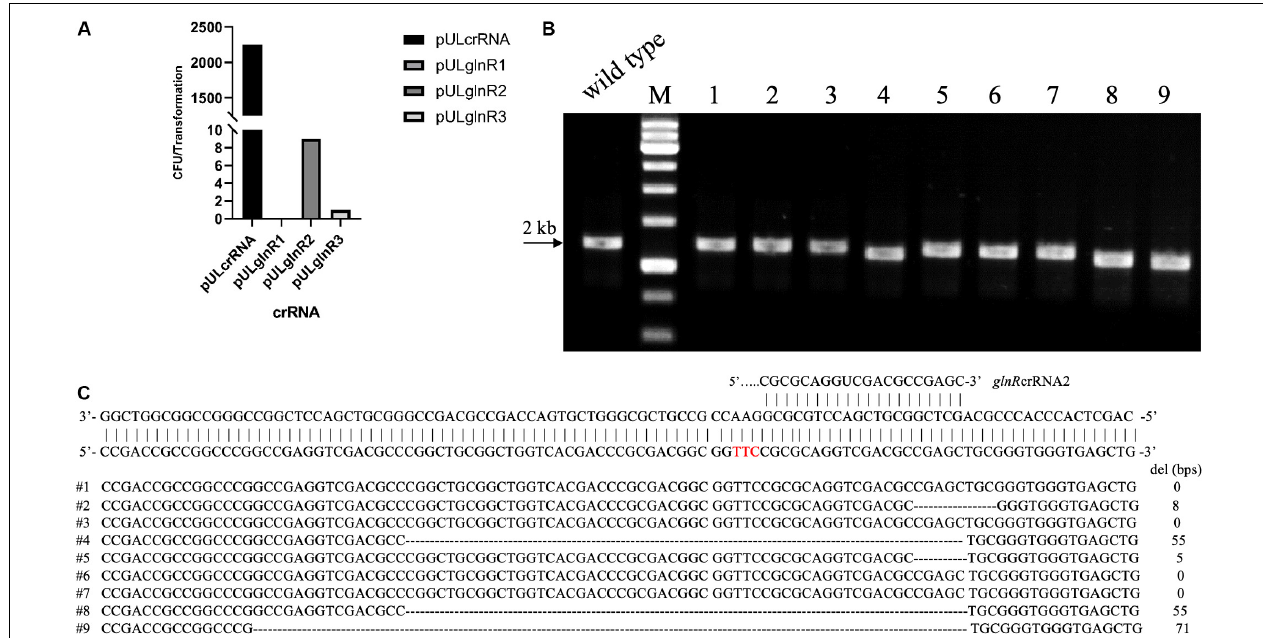
FIGURE 2 | CRISPR-Cas12a-assisted glnR deletion in combination with the NHEJ repair in A. mediterranei U32. (A) The number of transformants obtained with different crRNAs transformed. Plasmid pULcrRNA, which contained no crRNA guide sequences, was employed as a control plasmid. The number stood for the total colonies obtained from three transformation experiments, where no transformants were obtained with crRNA1. The guide sequences are listed in Supplementary Table S3 . (B) Characterization of pULglnR2 transformants by colony PCR amplification. M, GeneRuler 1 kb DNA Ladder (Thermo Scientific). Lanes 1–9, nine colonies transformed with CRISPR-Cas12a and pULglnR2 targeting glnR gene. (C) Sanger sequencing results of the PCR amplicons of the nine colonies in Figure 2B . Five colonies contained random deletion at the target site within glnR gene, which was repaired by the NHEJ pathway, and the deleted DNA sequences as well as the length were indicated. The PAM sequence was highlighted in